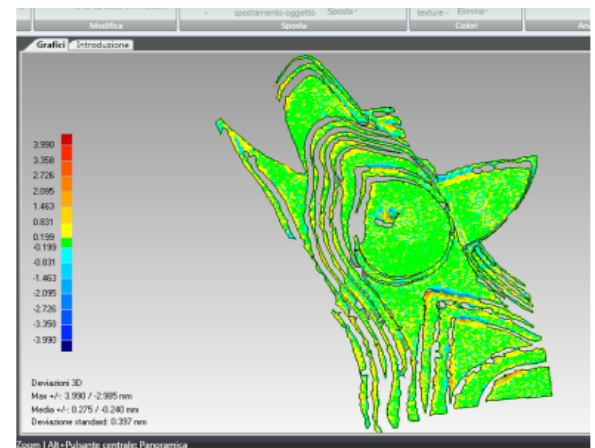
Figure 5. The point cloud of the Wolf of Sila , obtained by a single scan of TOF laser scanner